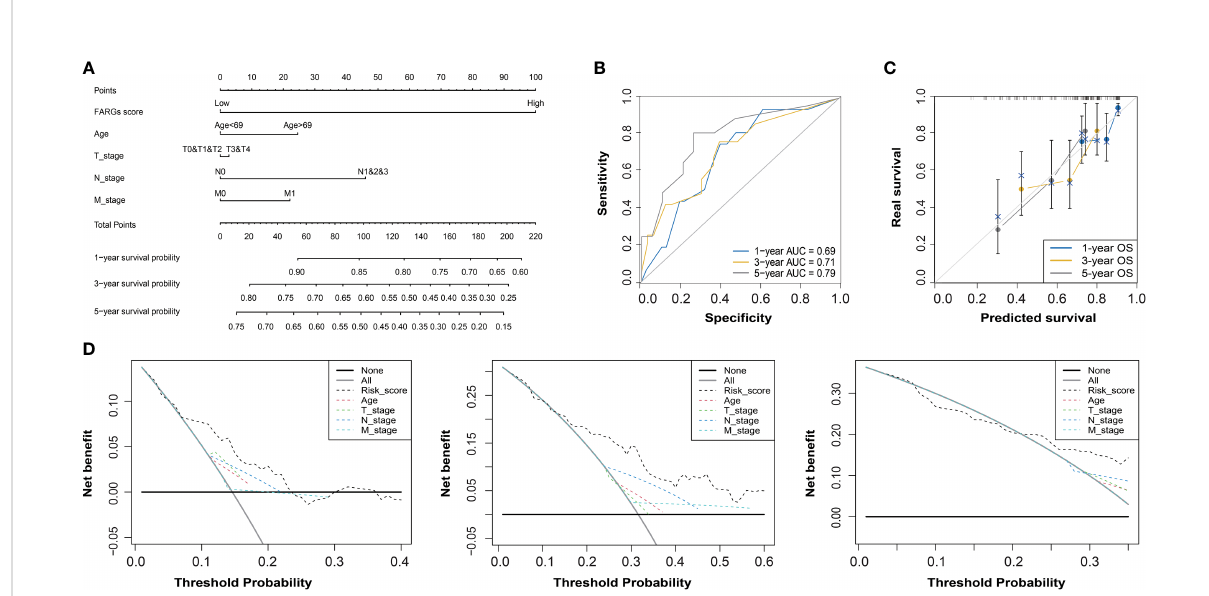
FIGURE 6 The construction and evaluation of a FARG-based nomogram. (A) Based on the independent prognostic factor of the FARG score together with clinical features of diagnosis age, and T, N, M stages, a novel nomogram was constructed. (B) The receiver operating characteristic curve analysis for evaluation of the FARG-based nomogram in prognosis prediction. (C) The calibration plots further estimated the ability of the FARG-based nomogram in prognosis prediction. (D) The decision curve analysis for the evaluation of the FARG-based nomogram in prognosis prediction.